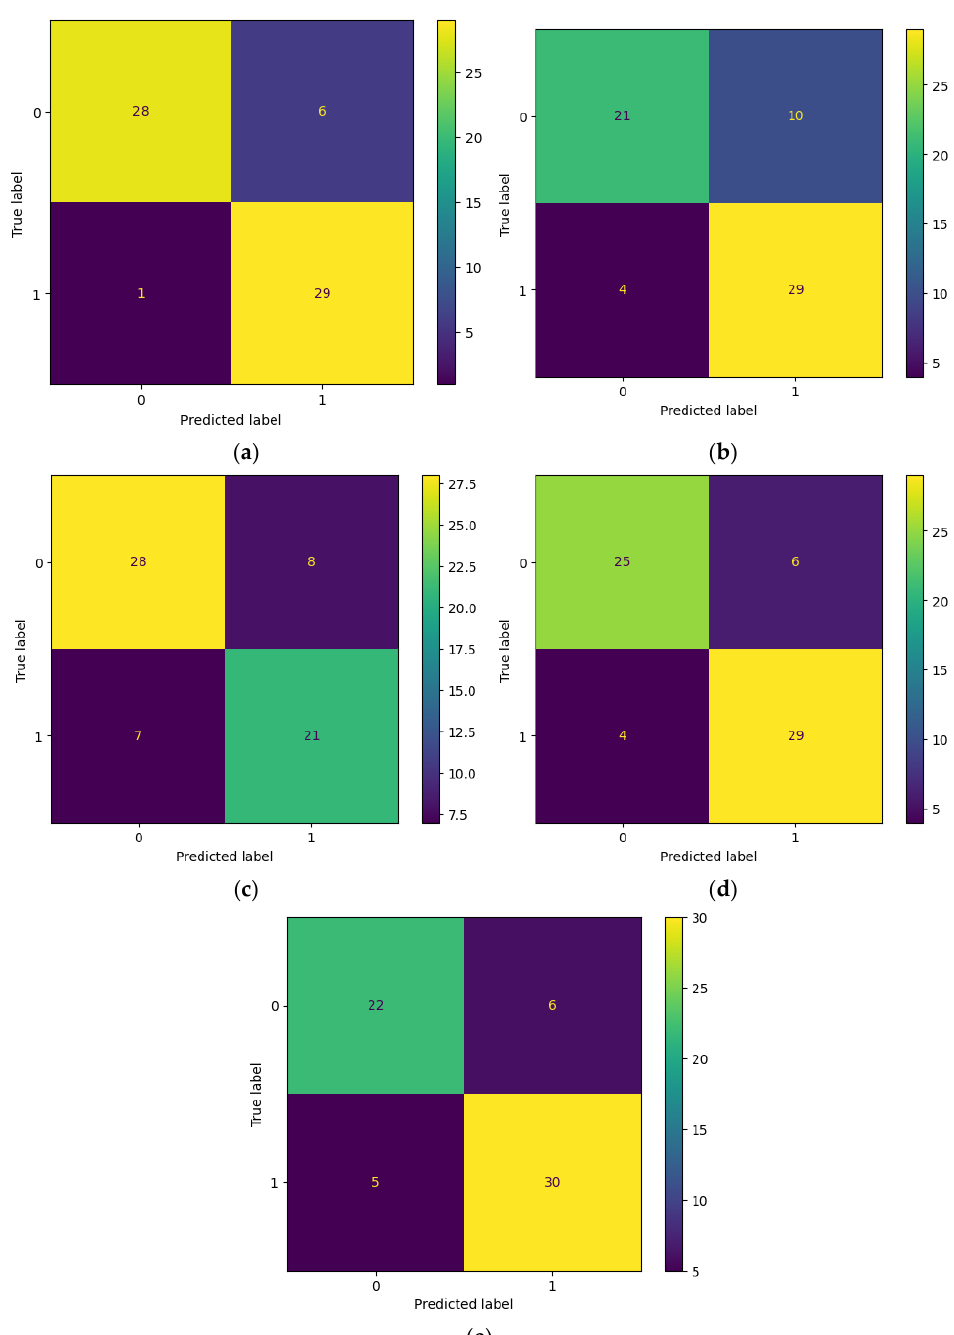
Figure 6. The confusion matrix for the validation sets of the ( a ) first, ( b ) second, ( c ) third, ( d ) fourth, and ( e ) fifth folds show that the number of false positives is greater than false negatives in all cases. Despite this, the consistency of false and true values suggests that the model is effectively identifying indicators for the sixth stage. It can be concluded that, with more data points, the number of false positives could be reduced significantly given that the only variable between each fold is the training and validation set.